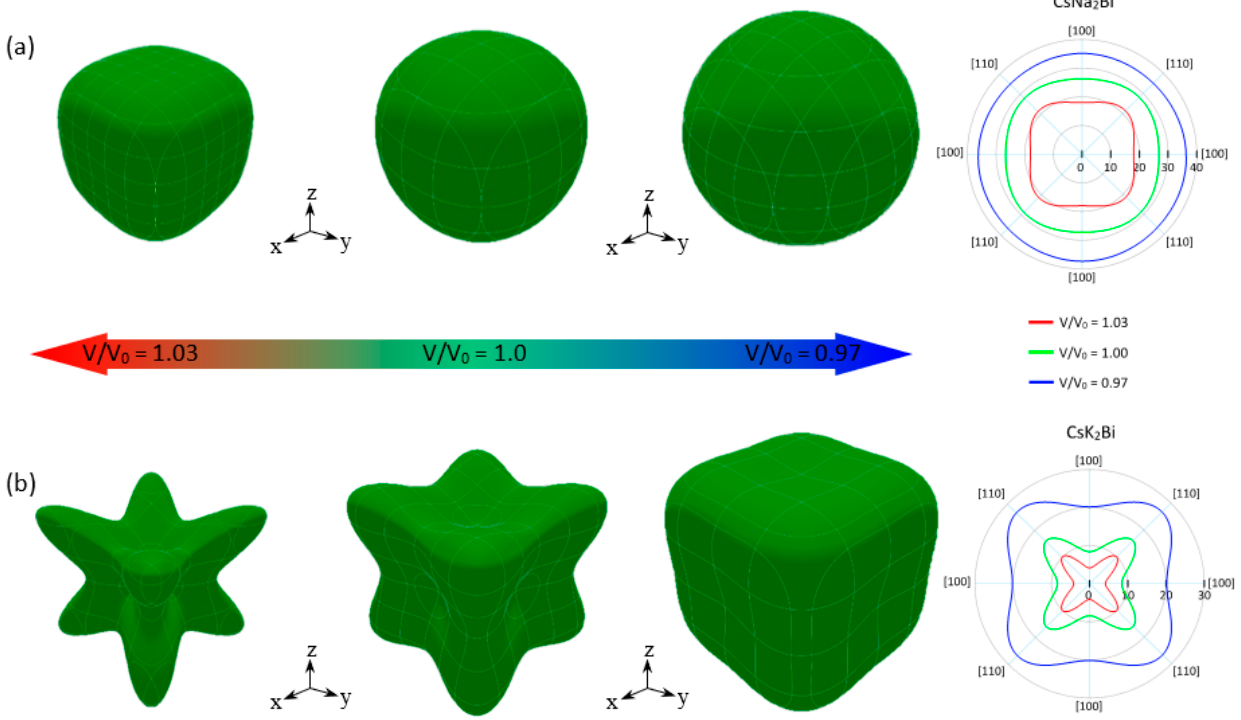
Figure 8. 3D representation and 2D projection (in xy-plane) of Young’s modulus of CsNa 2 Bi ( a ) and CsK 2 Bi ( b ) in equilibrium state (V/V 0 = 1.0), under hydrostatic compression (V/V 0 = 0.97), and tension (V/V 0 = 1.03). The behavior of anisotropy is understood from the shape of the three-dimensional (3D) plots. For isotropic materials, the 3D diagrams of Young’s modulus are expected to be perfectly spherical and its projections on different planes to be circular. The deviation from the spherical and circular shapes indicates anisotropy.